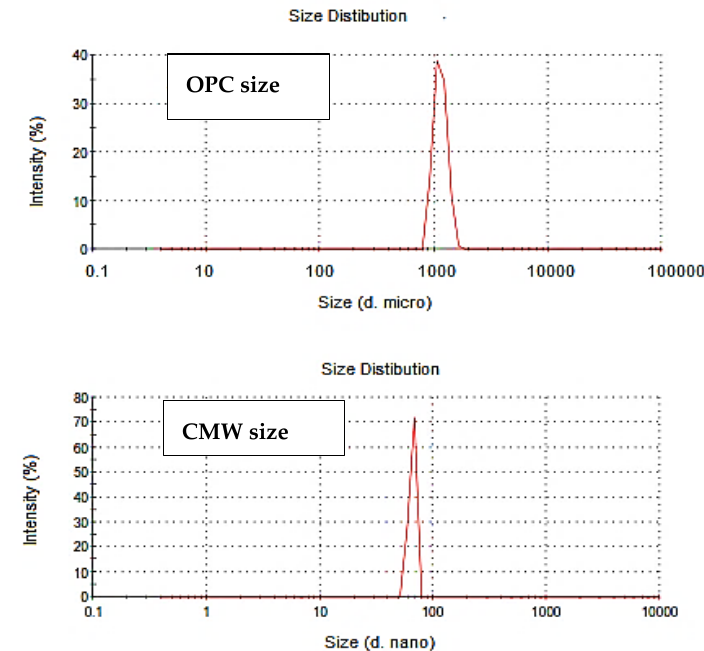
Figure 2. Particle size distribution of both cement and CMW after calcination.